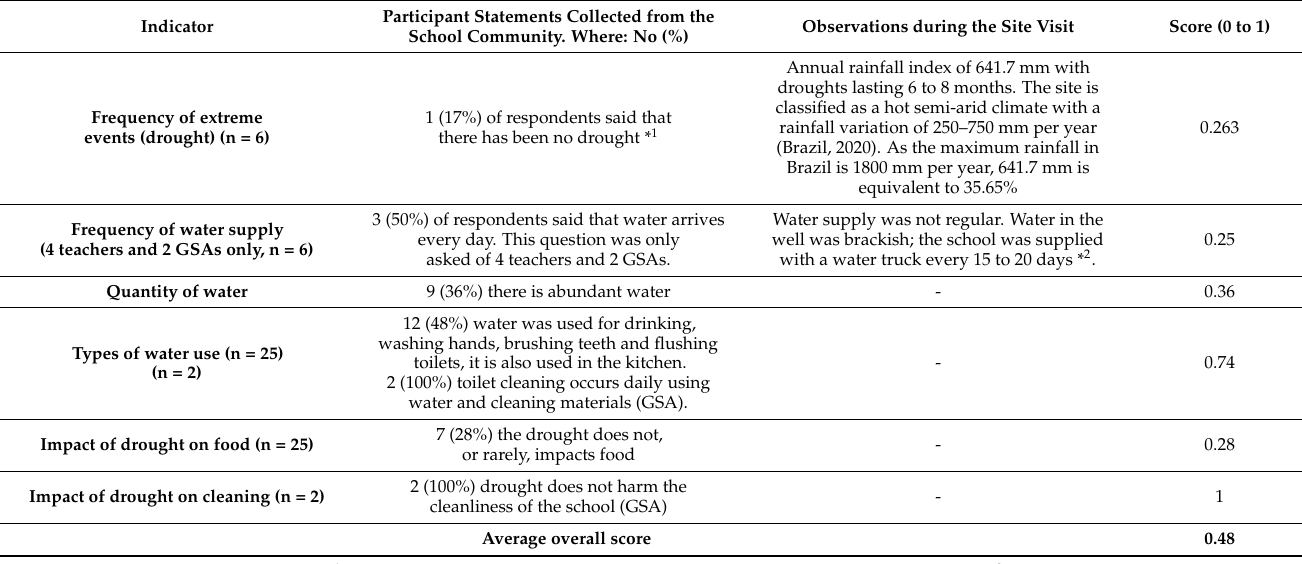
Table 5. Results of the survey carried out for the Environmental Dimension and its indicators. Weighting was 2; where n = total number of respondents.